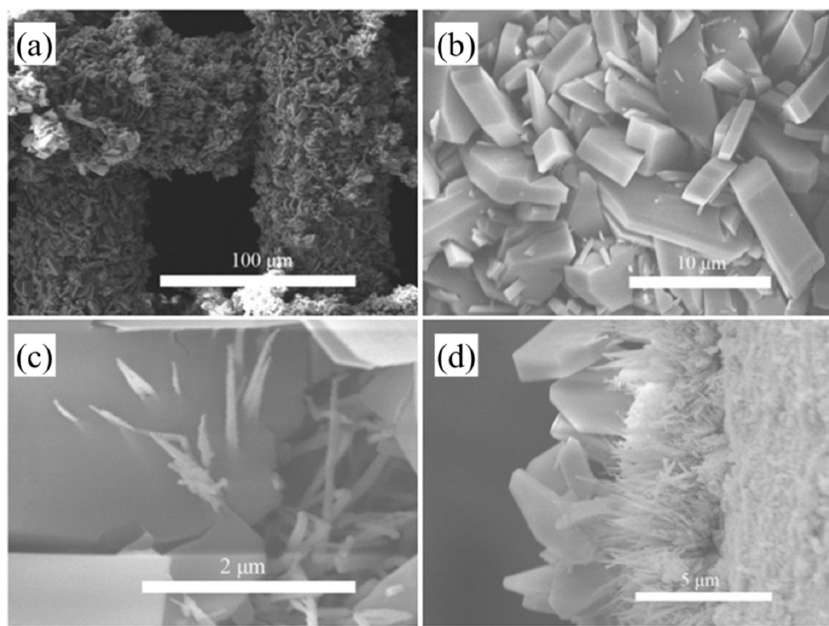
Figure 24. ( a , b ) SEM images of Eu-BCA thin-films on the stainless steel wire mesh (SSWM); ( c ) SEM image of Co 3 O 4 nanowire array-threaded Eu-BCA MOF crystal plates; ( d ) cross-sectional image of Eu-BCA thin films. Reprinted with permission from Reference [124]. Copyright 2017 WILEY-VCH Verlag GmbH & Co., (Weinheim,